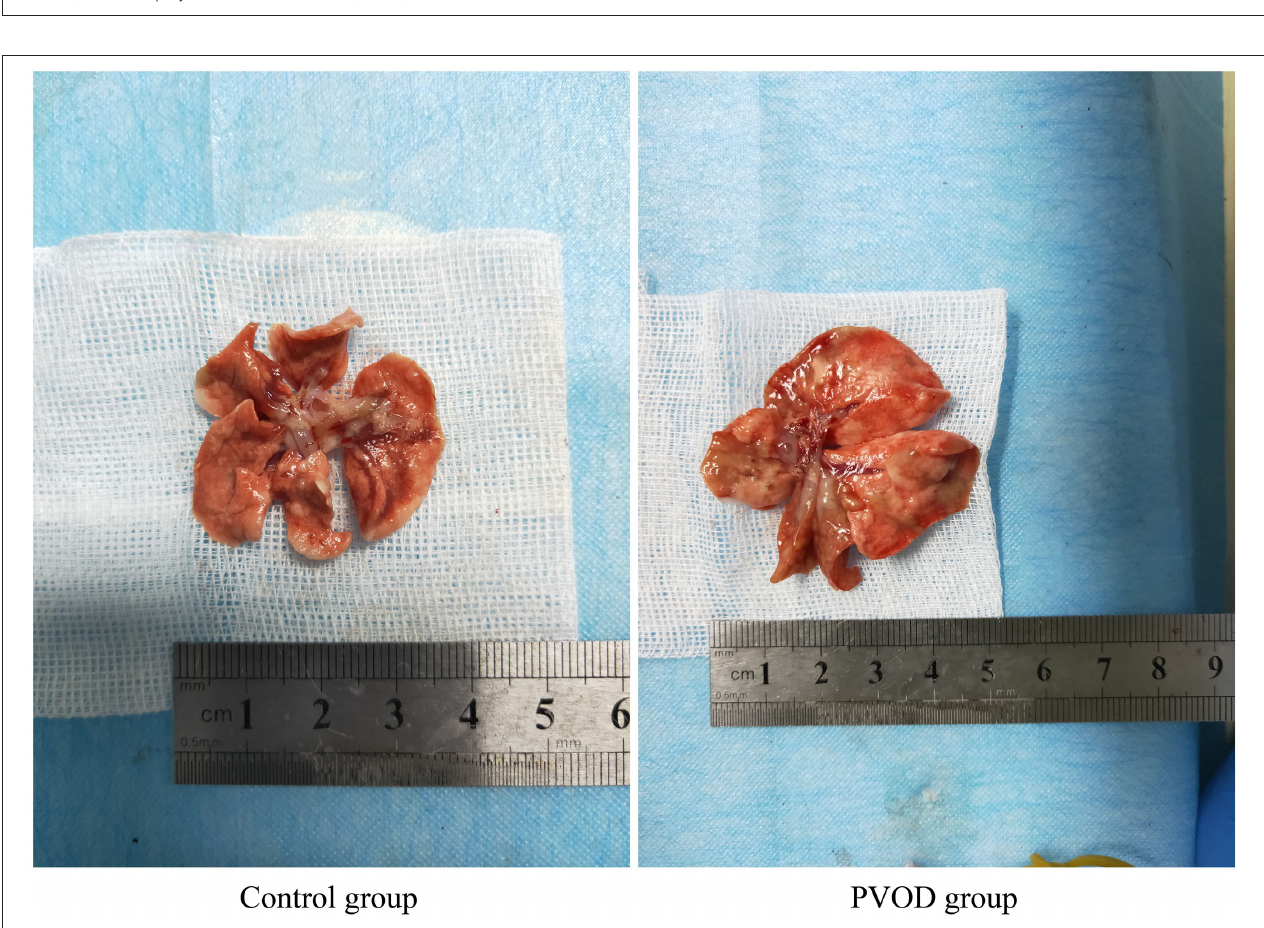
FIGURE 1 | Flowchart of study. The control group ( n = 4 rats) and the PVOD group ( n = 10 rats). PVOD, pulmonary veno-occlusive disease; GCN2, General control non-derepressible 2; mPAP, mean pulmonary arterial pressure; MMC, mitomycin-C; PBS, phosphate buffered solution; RVHI, right ventricular hypertrophy index;